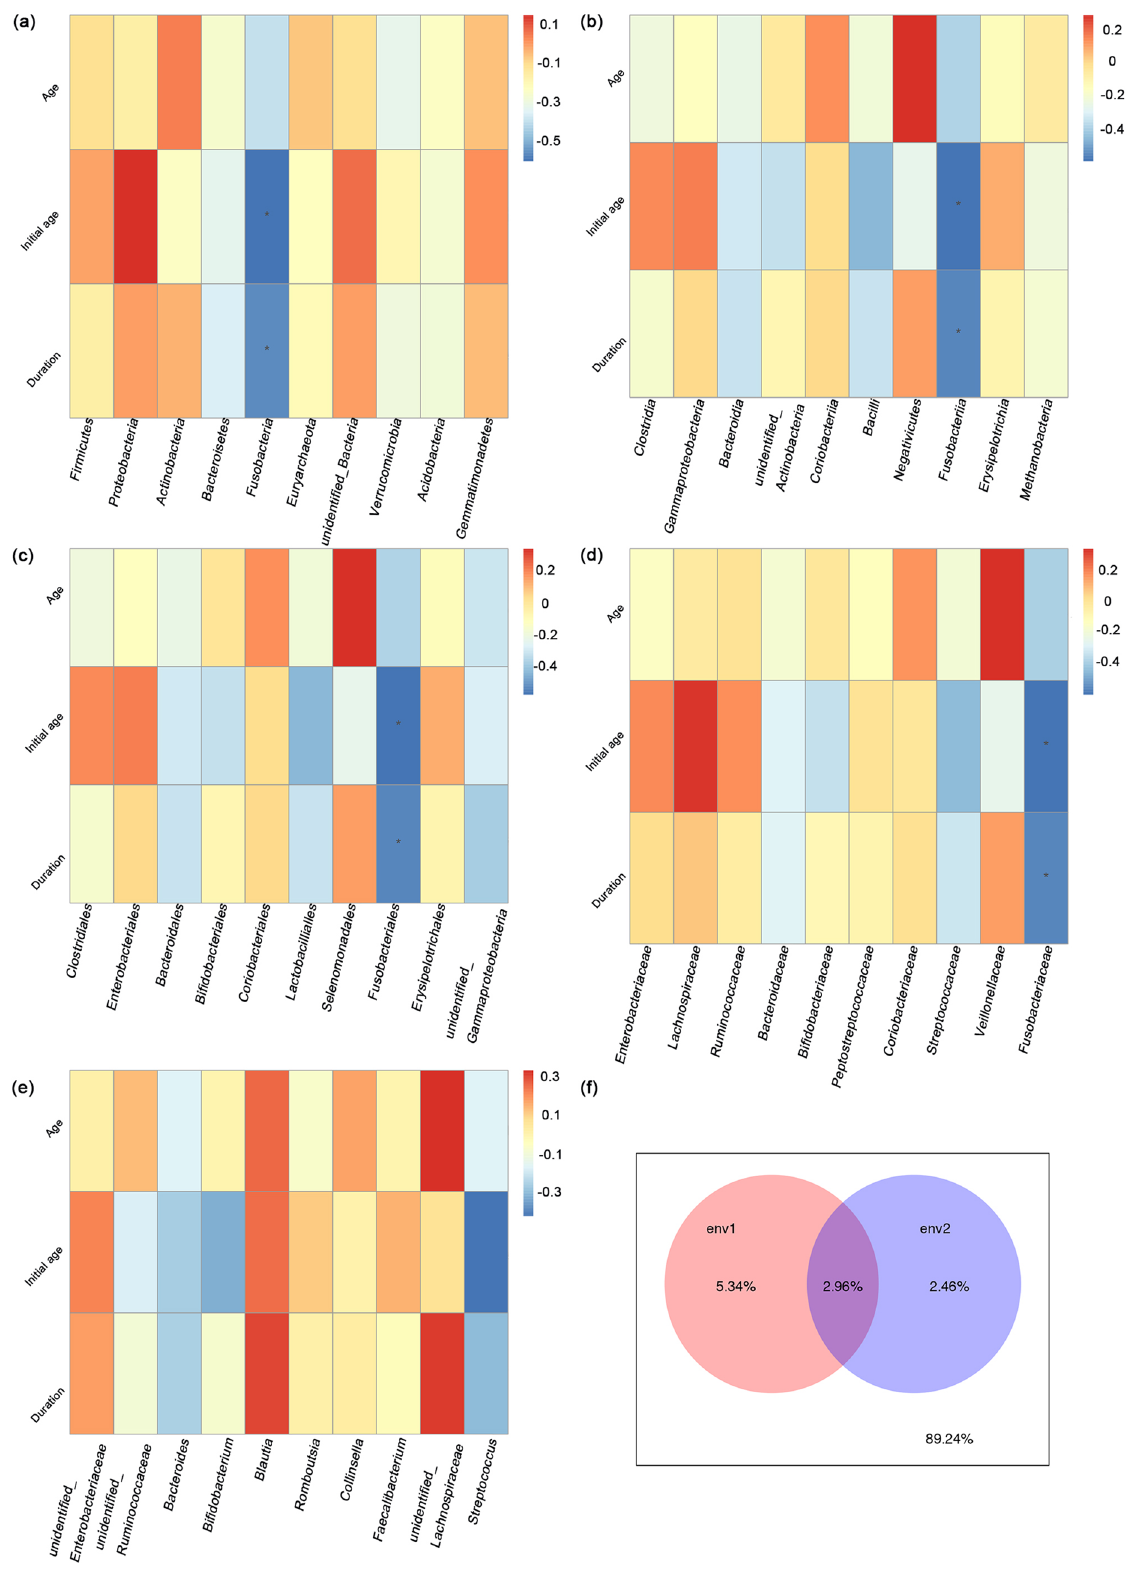
Figure 4. Gut microbiota may be associated with age and duration of METH use. The correlation between gut microbiota of different taxa and age, the initial age of METH use and duration of METH use (years) at the ( a ) phylum, ( b ) class, ( c ) order, ( d ) family, and e genus levels. The ordinate represents age (Age), initial age of METH use (Initial age) and duration of METH use (Duration). The abscissa represents the species information. Spearman rank correlation, * p < 0.05. ( f ) VPA showed that age (env2) contributed less to the microbial community than did the duration of METH use (env1). The intersecting part of the circle is the common explanatory quantity of env1 and env2, while the outside of the circle is the unexplainable